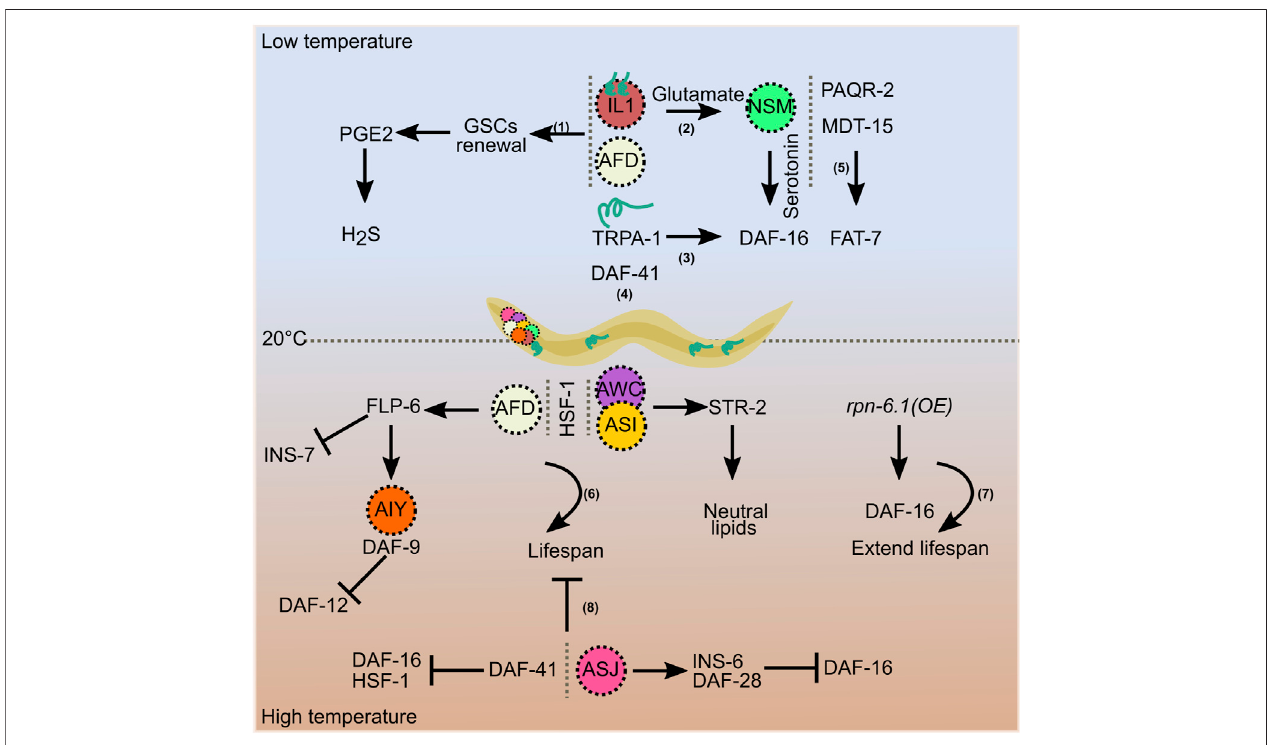
FIGURE 2 | Temperature-dependent regulation of longevity. Increased lifespan at low temperatures is regulated by signals involving germline stem cells (1), AFD and IL1 neurons (1 and 2), TRPA-1 (3), the co-chaperone DAF-41 (4), and fatty acids (5). AFD, AWC, and ASI neurons, and HSF-1 maintain lifespan at higher temperatures (6), overexpression of rpn-6.1 prolongs it (7), and ASJ neurons and DAF-41 shorten lifespan at higher temperatures (8).